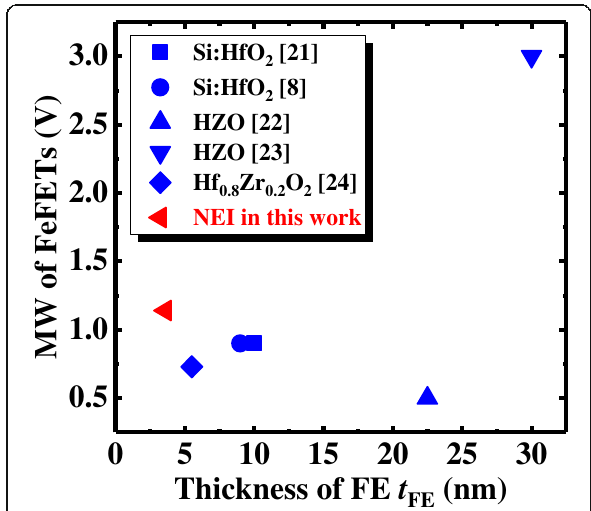
Fig. 12 Benchmarking of NEI FeFET memory device against reported FeFETs, with regard to MW and t FE . Thinnest FE is